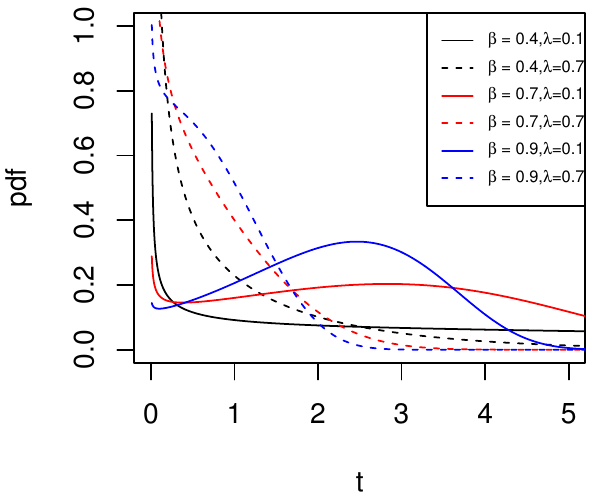
Figure 1. pdf of Chen ( t ; β , λ ) ,0 < β <